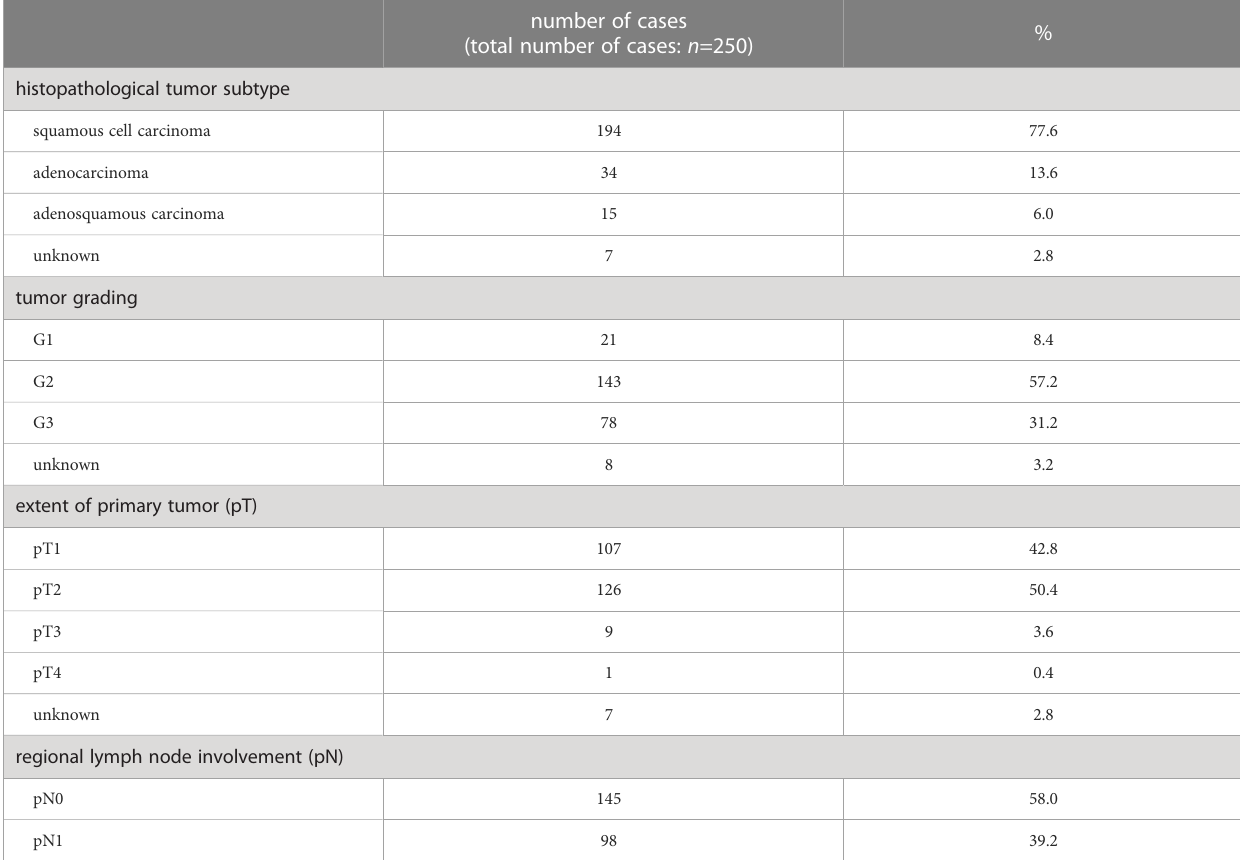
TABLE 1 Description of clinical and pathological variables of the patients.